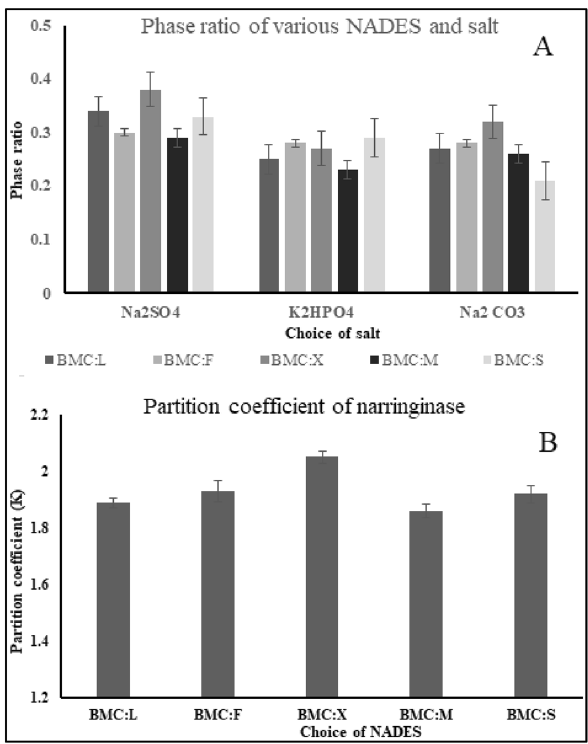
Figure 2. The influence of NADES and salt type on the phase ratio ( A ) and partition coefficient ( B ) for naringinase obtained through extractive fermentation. The yield differs based on the choice of NADES and salt proving the selectivity of the system toward